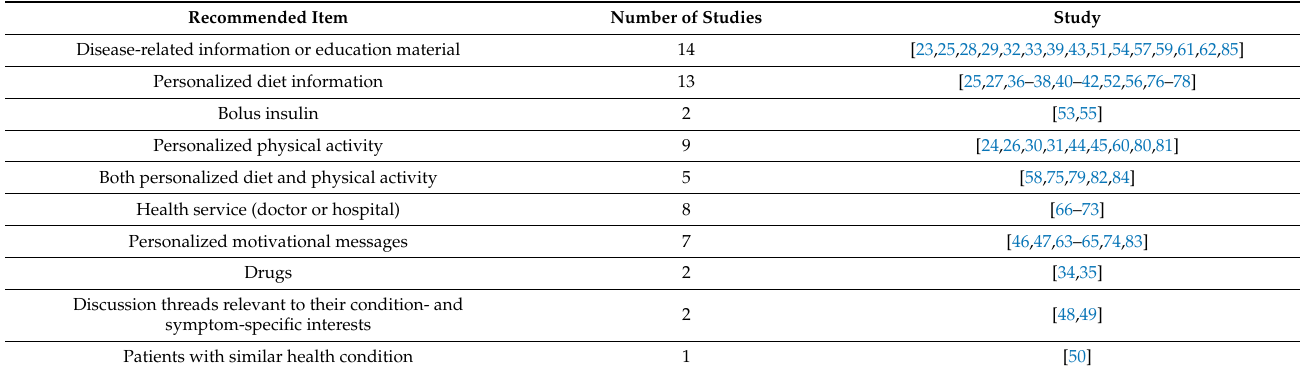
Table 4. The distribution of recommended